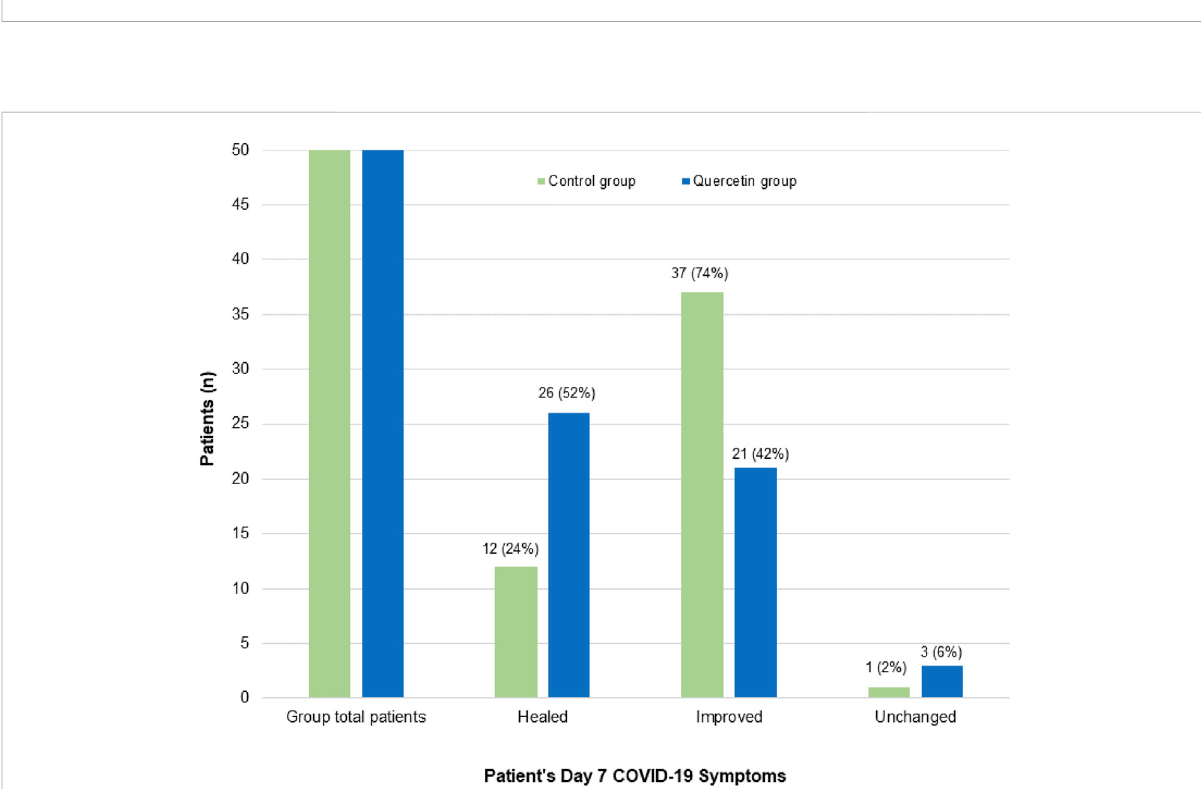
FIGURE 4 Patient ’ sDay7follow-upCOVID-19-associatedsymptomsinthetwotreatmentgroups.Healed:PatientswhomanifestedoneormoreCOVID- 19 associated symptoms at baseline, but no symptoms on Day 7; Improved: Patients who showed fewer symptoms on Day 7 than baseline; Unchanged: Patients who have no treatment effect on their COVID-19